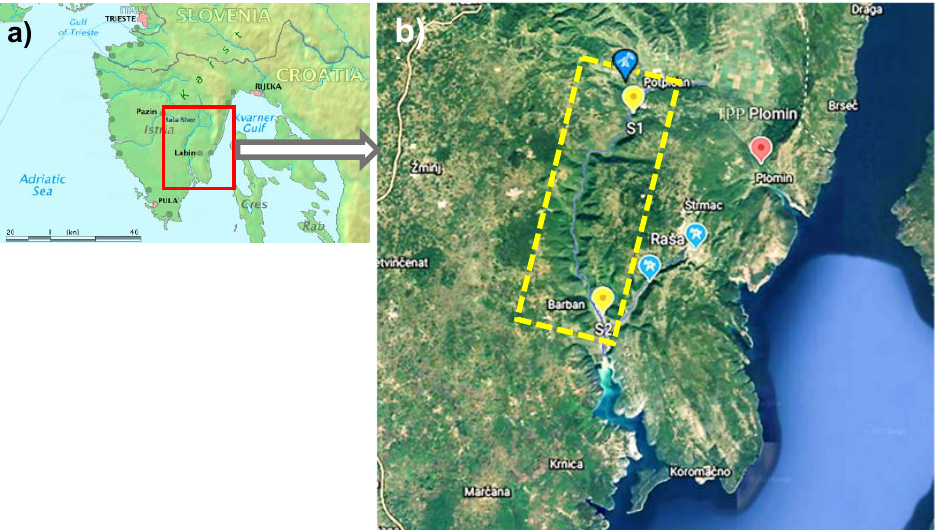
Figure 1. Map of the study area. ( a ) Istrian Peninsula with Raša River (Map modified from Wikipedia), ( b ) Western part of the Raša River basin (yellow rectangle marked with a dashed line), with locations of sampling sites on the Raša River ( ), together with locations of former mines in Raša, Labin and Tupljak ( ) and Thermal Power Plant in Plomin ( ) (Map modified from Google Earth).